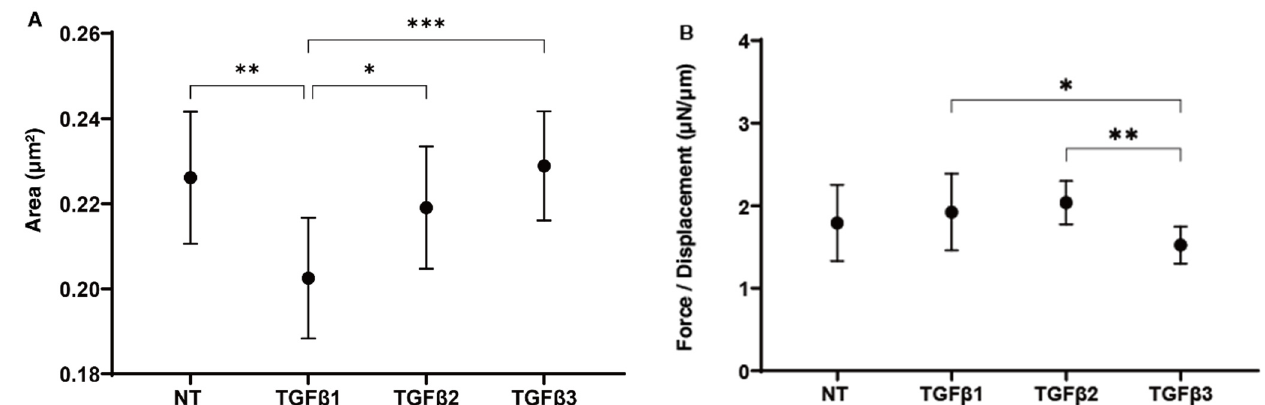
Figure 3. Effects of TGF- β isoforms on the physical properties, i.e., size ( A ) and stiffness ( B ), of 3D HTM spheroids. Among the non-treated control (NT) cultures and cultures treated with 10 ng/mL TGF- β -1, 5 ng/mL TGF- β -2, or 1 ng/mL TGF- β -3, the mean sizes of the 3D HTM spheroids are plotted in panel ( A ). Under these conditions, the stiffness of 3D HTM spheroids, based on the force required ( µ N) to induce a 50% deformity in diameter, was measured by a micro-squeezer, and force/displacement ( µ N/ µ m) values are plotted in panel ( B ). These experiments were performed in triplicate using fresh preparations (n = 10, total 30, and 15, total 45, for size measurement and stiffness respectively). * p < 0.05; ** p < 0.01; *** p < 0.005.